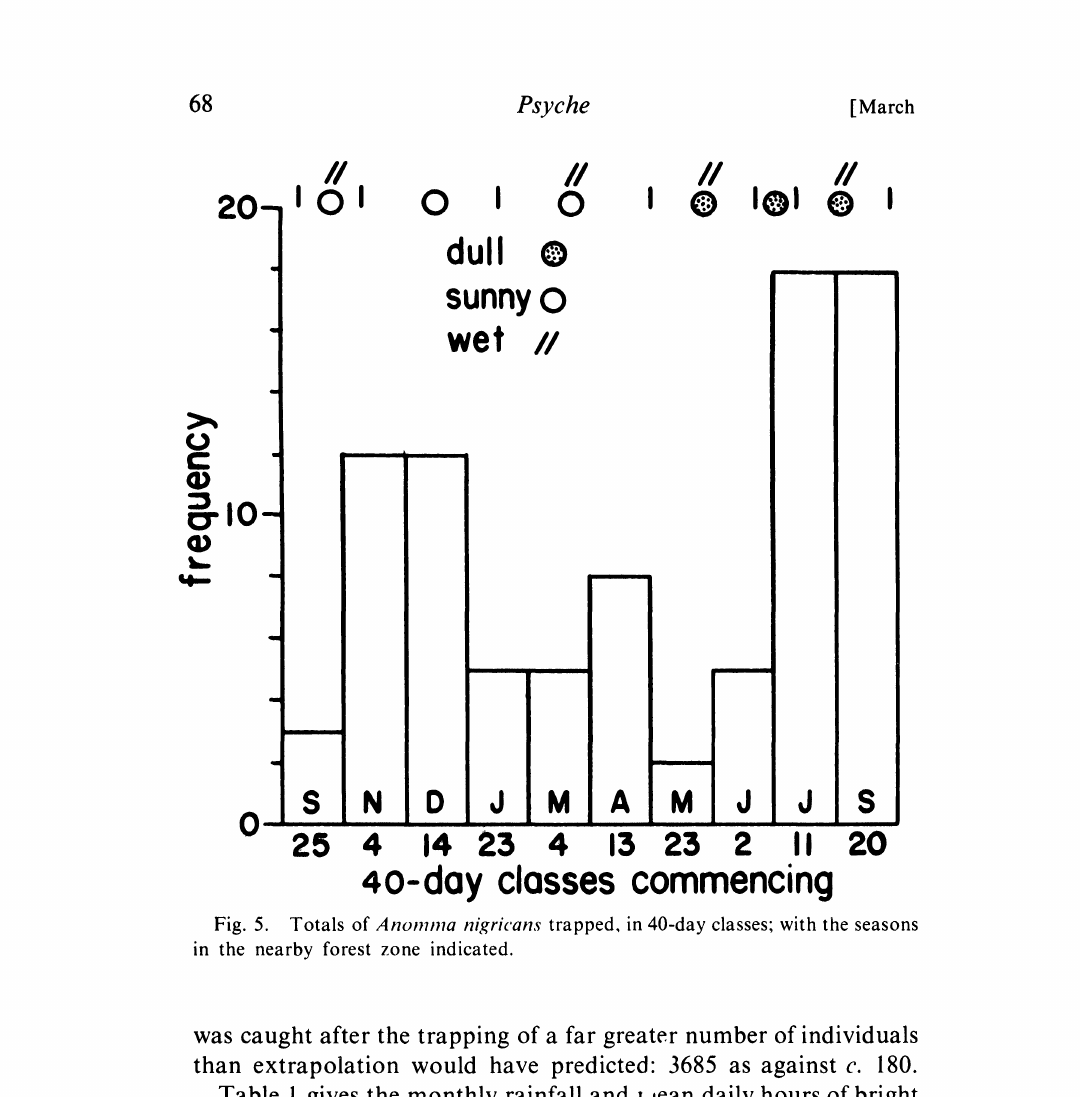
was caught after the trapping of a far greater number of individuals than extrapolation would have predicted: 3685 as against c. 180. gives the monthly rainfall and x,ean daily hours of bright sunshine per month for the period under review: by bright sunshine is meant sunshine as measured by a Campbell-Stokes’ or similar apparatus. The rainfall and monthly totals of Alaopone atriceps were compared, using Spearman’s rank correlation: n-- 13 R- 317